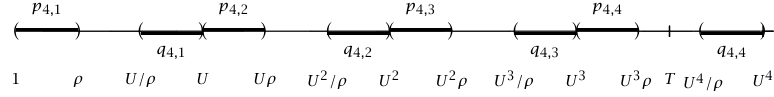
Figure 4.1 . The distributions F and G of Theorem 4.1, with n =